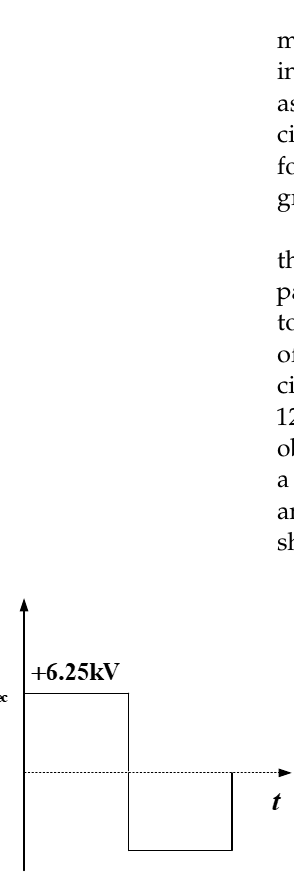
Figure 6. Gain curve of the proposed parallel resonant converter.